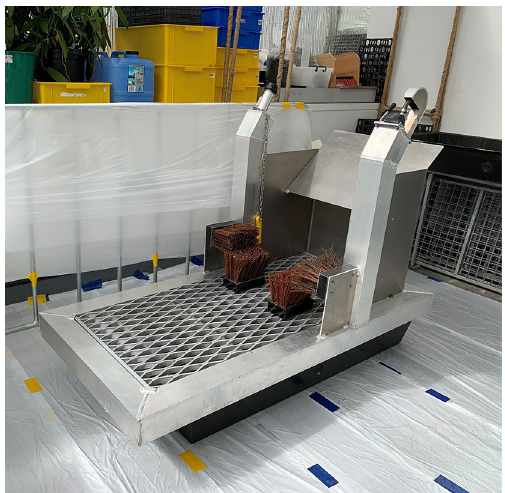
Figure 6. Hygiene station used in the study. The whole machine was placed on top of a large sturdy tub to catch soil particles through the grate. Note the fixed boot brushes, and the disinfectant spray lever on the